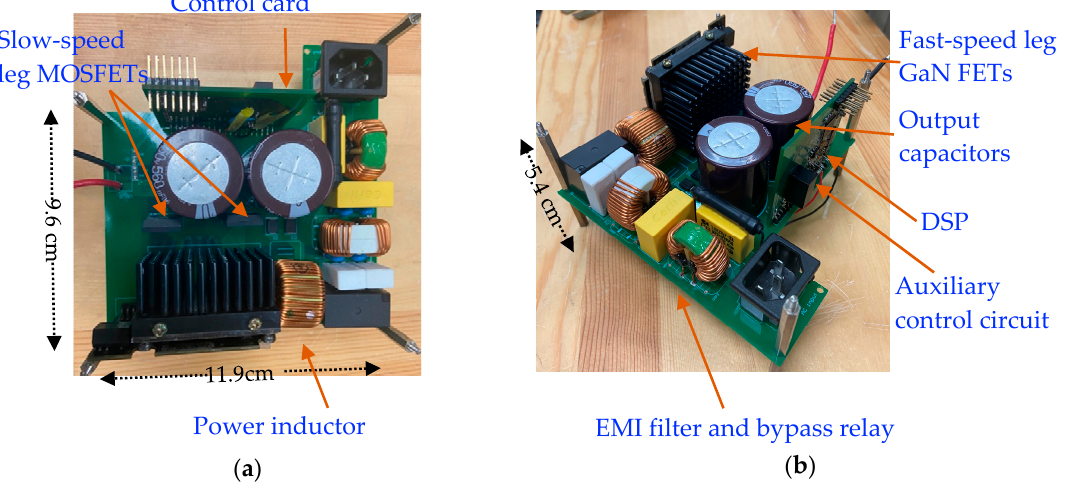
Table 1. The specification and the parameters of the design.